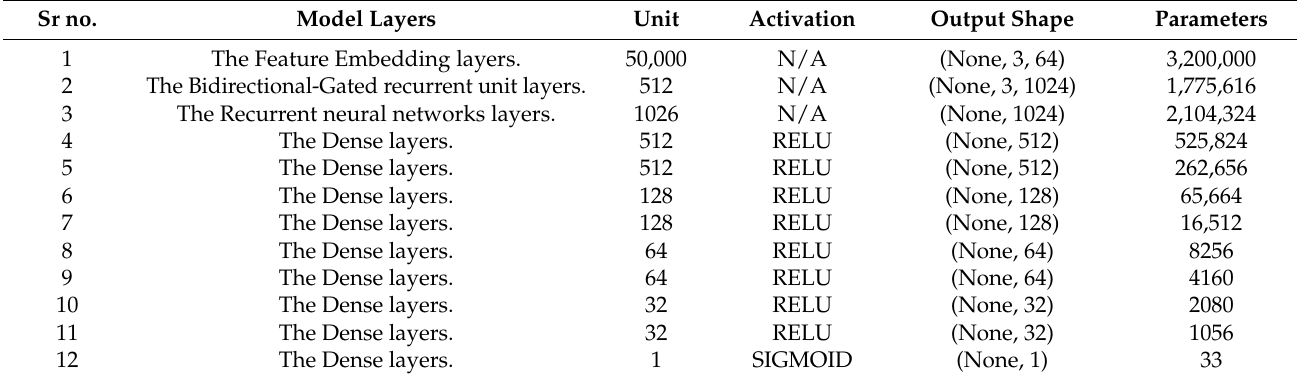
Table 6. The Deep BiGR model hyperparameter configuration